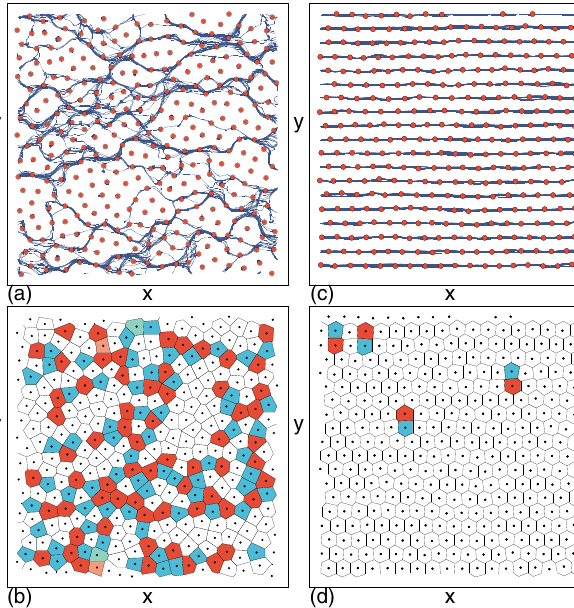
Fig. 7 Disordered and 1 + 1 dimensional fl ow below and above the dynamical phase transition. a The colloid positions (red circles) and trajectories (lines) for a subset of the system in Fig. 5 with colloid density n = 1.0, pinning density n = 0.5, pinning force F = 1.0, and pinning radius c p p r = 0.35 at a quench time of t = 7.5 × 10 5 and a driving force of F = 0.25, p q D showing 2D disordered fl ow. b The corresponding Voronoi plot showing a high defect density. c The colloid positions and trajectories in the same system at F D = 1.5 showing 1D channeling. d The corresponding Voronoi plot shows that all of the topological defects are aligned in the same